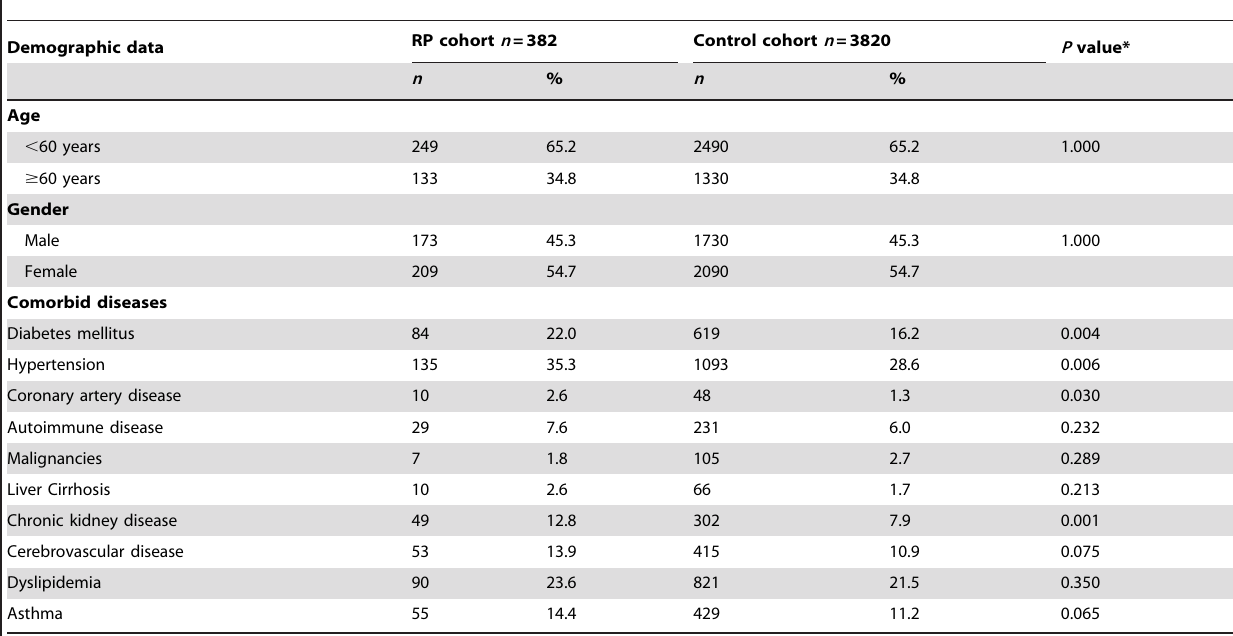
Table 1. Baseline characteristics and comorbid medical disorders of patients with retinitis pigmentosa (RP) and the control cohort.